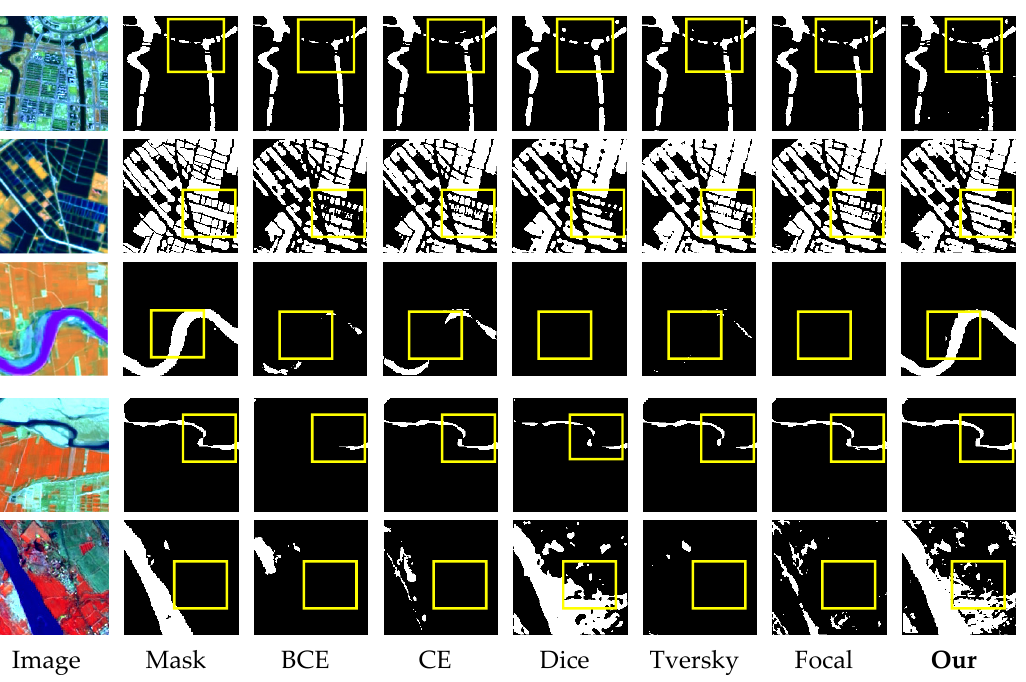
Figure 16. Example of U-Net network segmenting water bodies using 6 different loss functions.